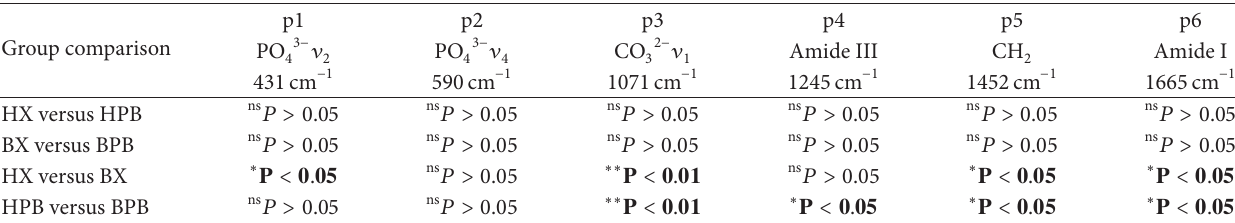
T 3: Statistical results of the Dunn’s Multiple Comparisons post-hoc test evaluation of integrated areas of the Raman peaks of the groups treated with adhesives (signi�cant comparisons are in